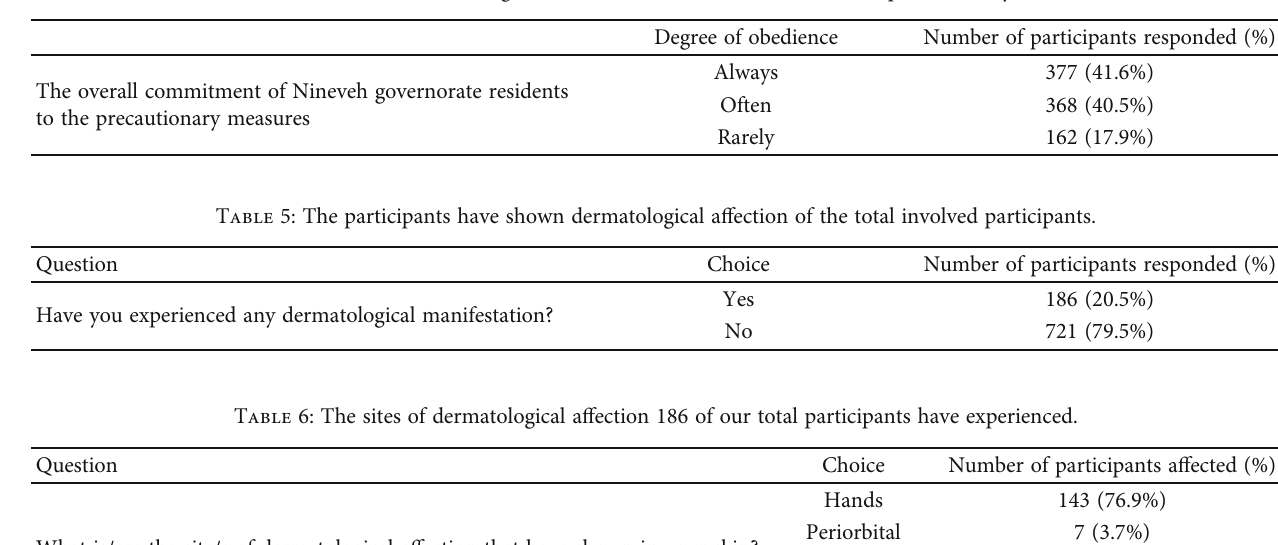
Table 4: Evaluation of Nineveh governorate residence commitment to the precautionary measures.